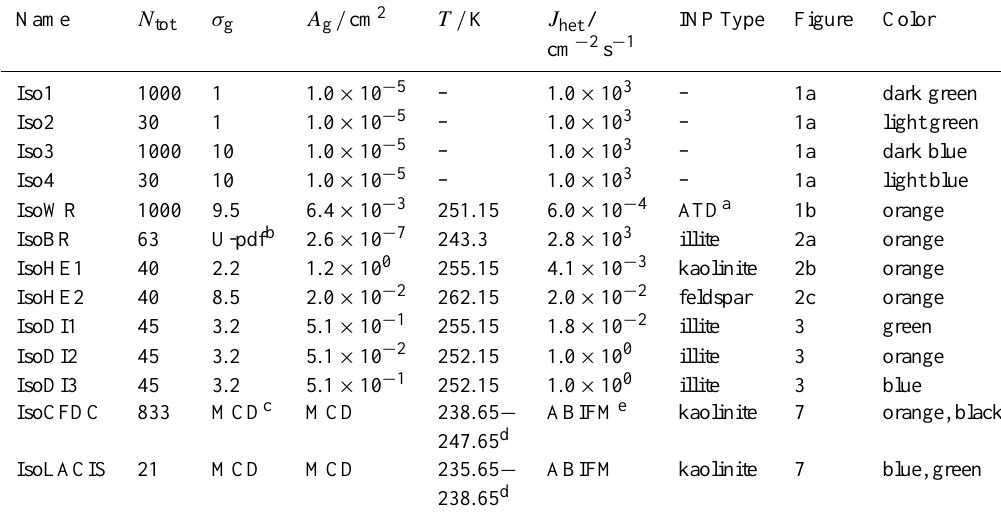
Table 1. Summary of parameters used in isothermal model